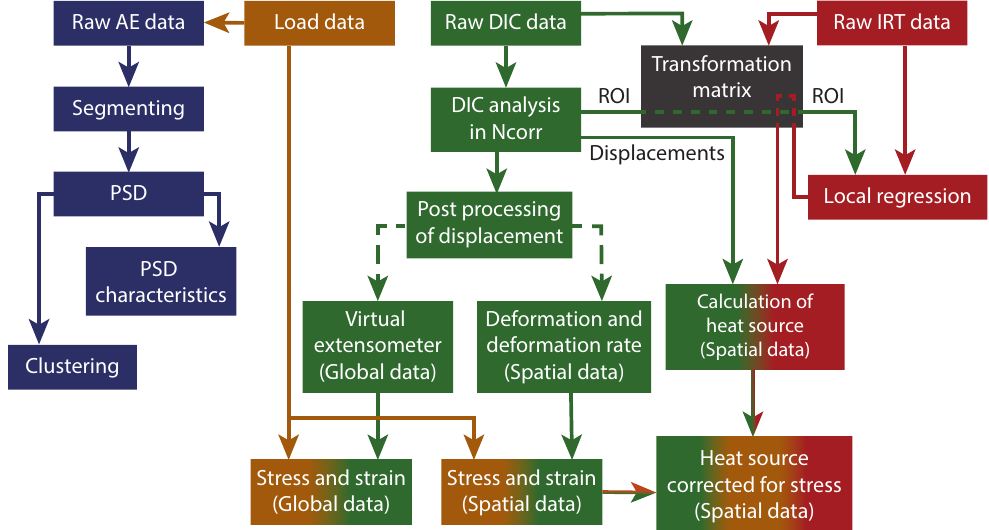
Figure 3. Flow-chart of data processing for the tensile